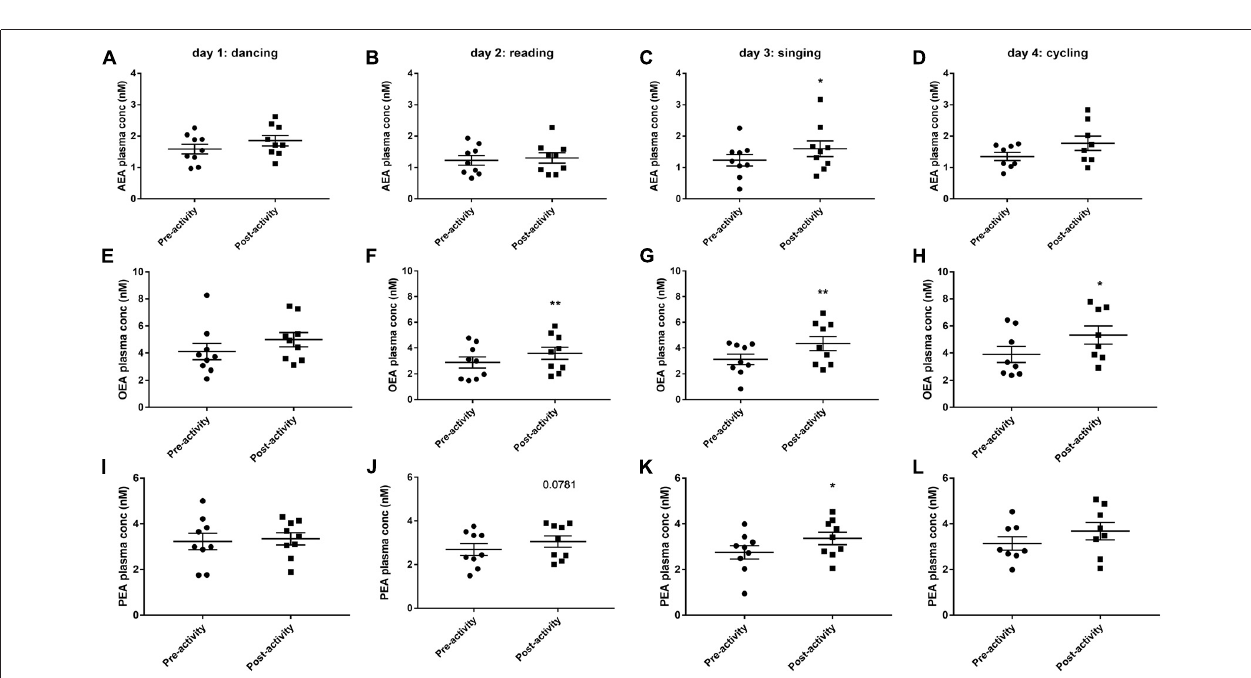
FIGURE 4 | Plasma endocannabinoid levels (AEA, anandamide, A–D ; OEA, oleoylethanolamine, E–H ; PEA, palmitoylethanolamine, I–L ) before and after 30 min activity (dancing, reading, singing or cycling) in nine healthy female volunteers. Data is presented as a scatter plot with mean ± SEM. Data sets were compared by paired Student’s t -test pre and post-activity ( ∗ P < 0.05, ∗∗ P <